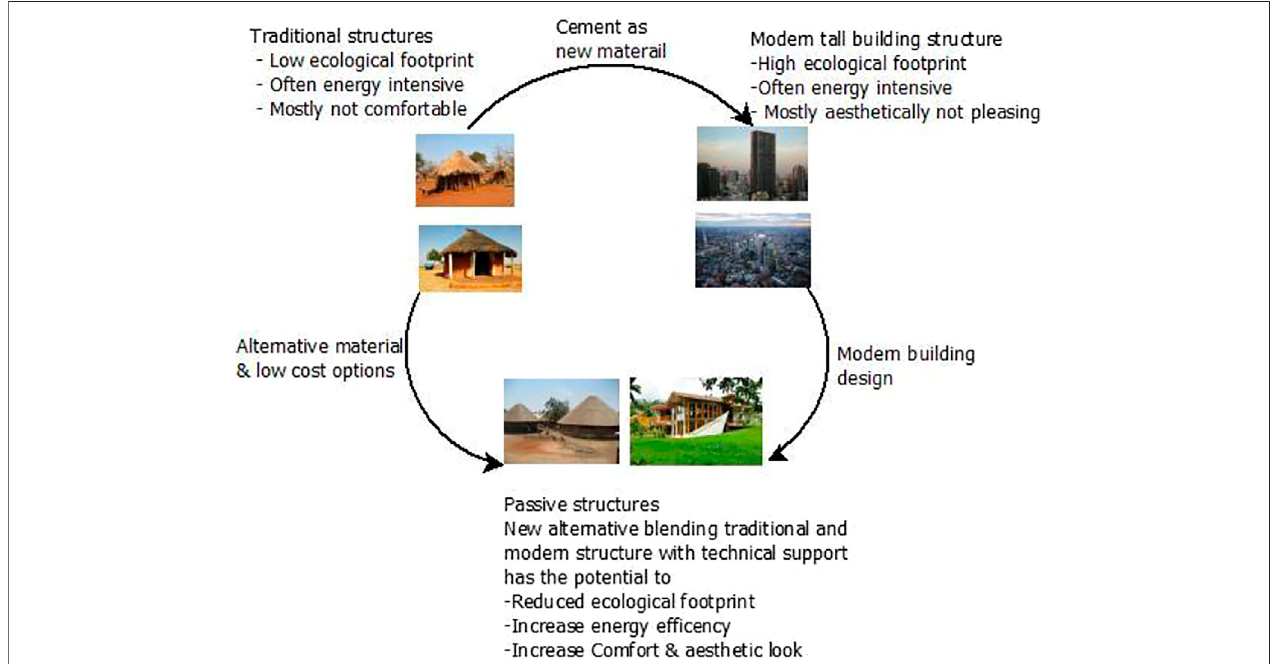
FIGURE 6 | Illustration and scoping the future using Wikipedia